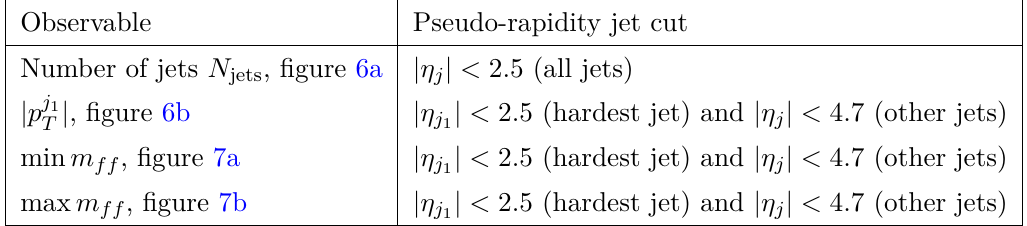
Table 3. Pseudo-rapidity jet cuts used for the 13 TeV analysis observables presented in this section, following the CMS analysis of [31,